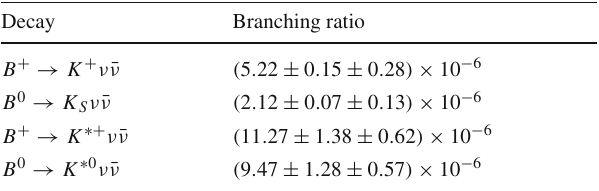
Table 2 Our final predictions for the branching fractions of the most relevant b → s ν ¯ ν decay modes. The first uncertainty comes from the hadronic form factors and the second one is dominated by the uncer- tainty of | λ t |